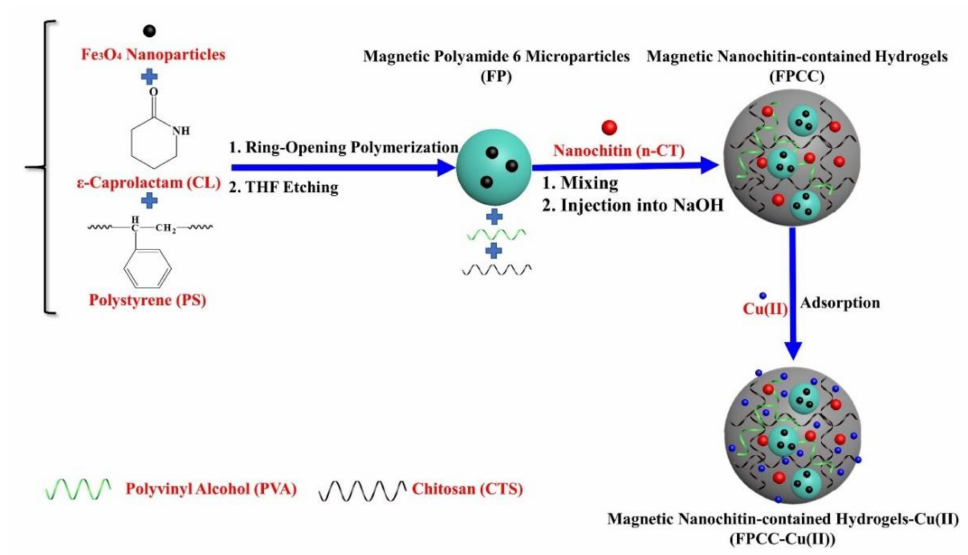
Figure 9. Schematic representation of preparation of the magnetic nanochitin-contained hydrogels (FPCC) and their adsorption ability to metal cations. Reprinted from